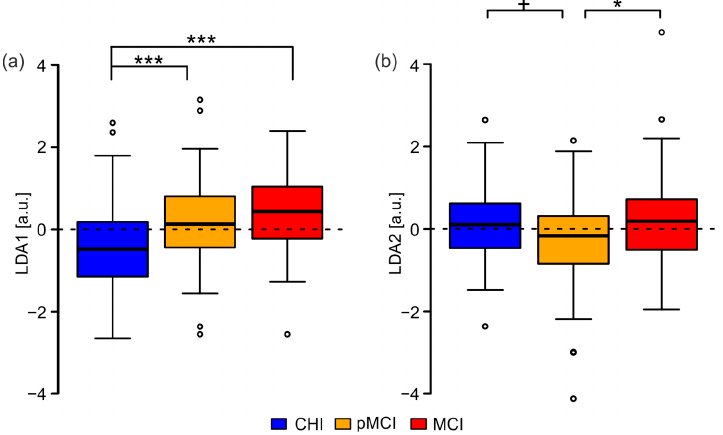
Figure 2. Boxplot of the LDA scales per group. ( a ) LDA1; ( b ) LDA2. CHI: cognitively healthy indi ‐ viduals; pMCI: participants with possible mild cognitive impairments; MCI: participants with mild